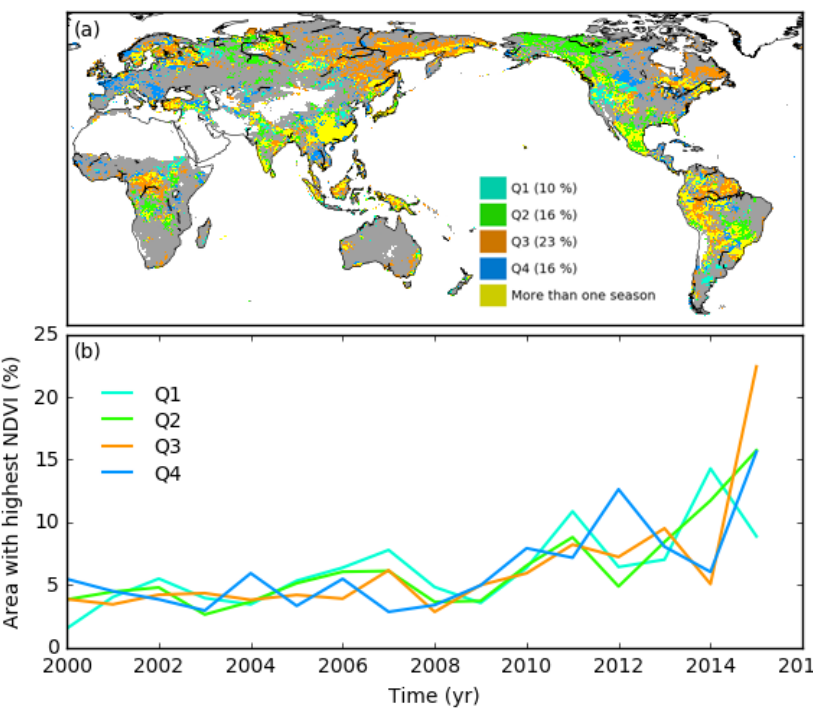
Figure 1. Year 2015 as the greenest year for the period 2000–2015. (a) Distribution of seasons for which 2015 NDVI ranks the highest during the period 2000–2015. Yellow-coloured pixels indicate grid cells where 2015 NDVI ranks highest for more than one season. For each season, the fraction of global vegetated land area for which 2015 NDVI ranks highest is shown in the coloured legend. (b) Temporal evolution of the percentage of vegetated land with highest NDVI for 2000–2015 for each season and different years. The sum total of vertical-axis values for each season over all years is 100%. Q1 is January–March, Q2 is April–June, Q3 is July–September and Q4 is